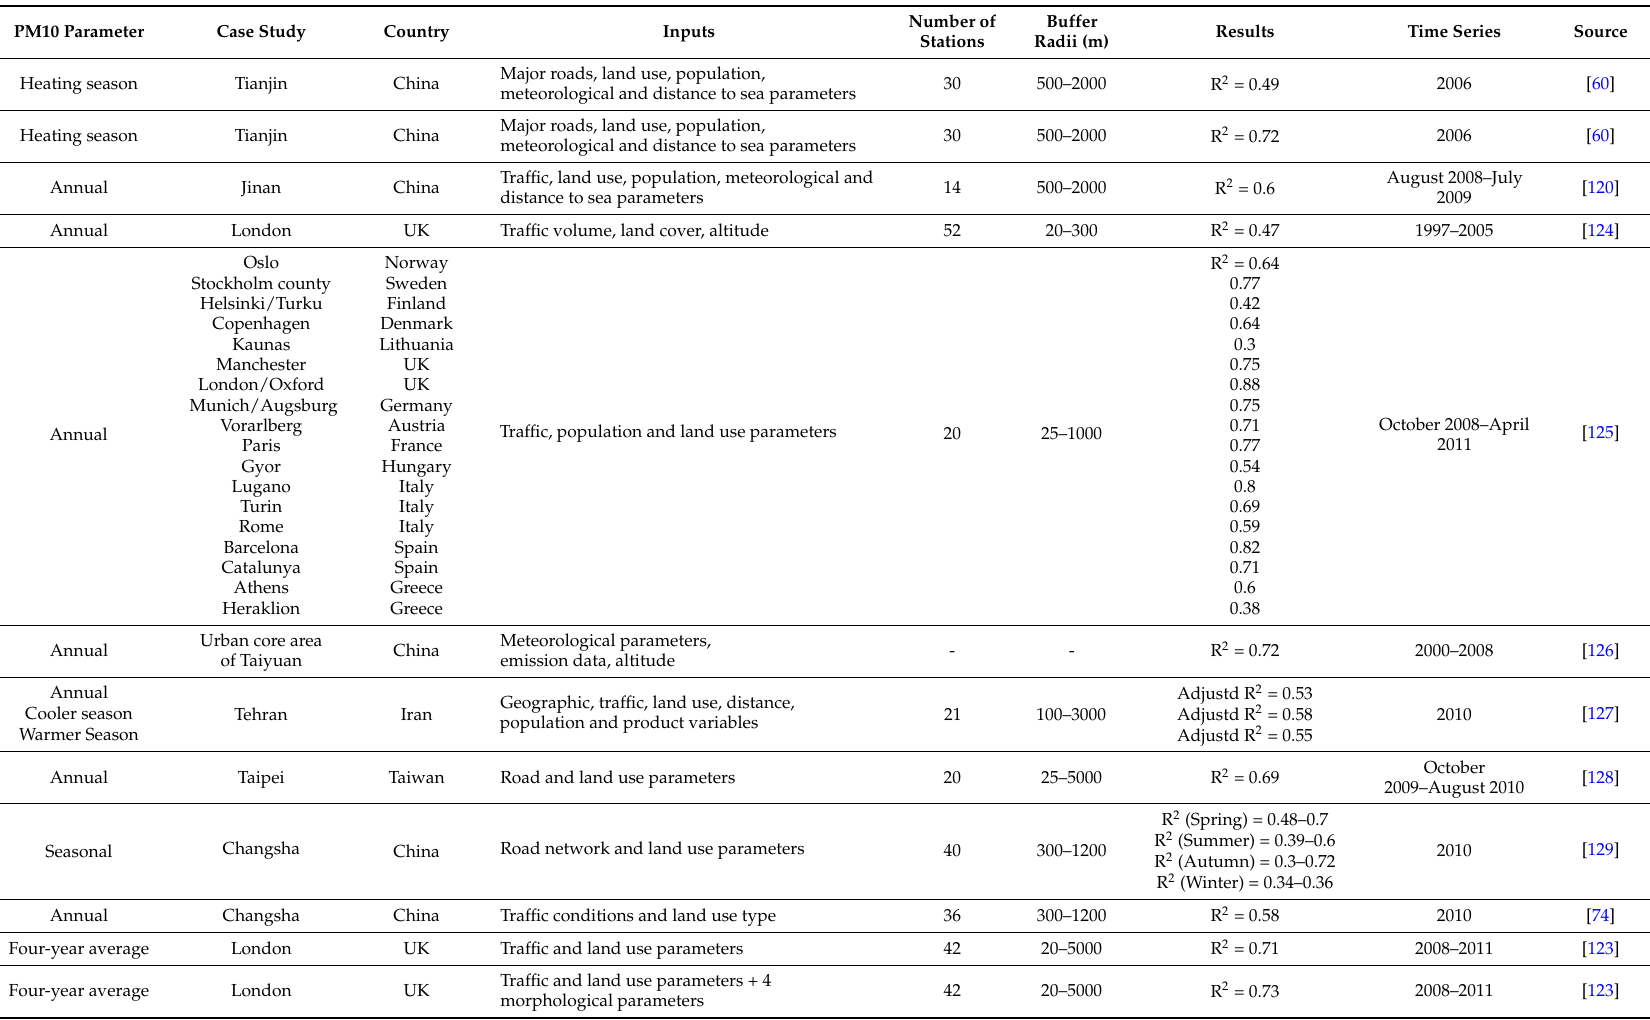
Table 4. Recent studies on the spatial modeling of PM 10 in urban